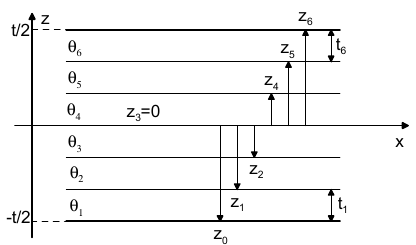
Figure A1. The laminate cross-section ( N = 6).